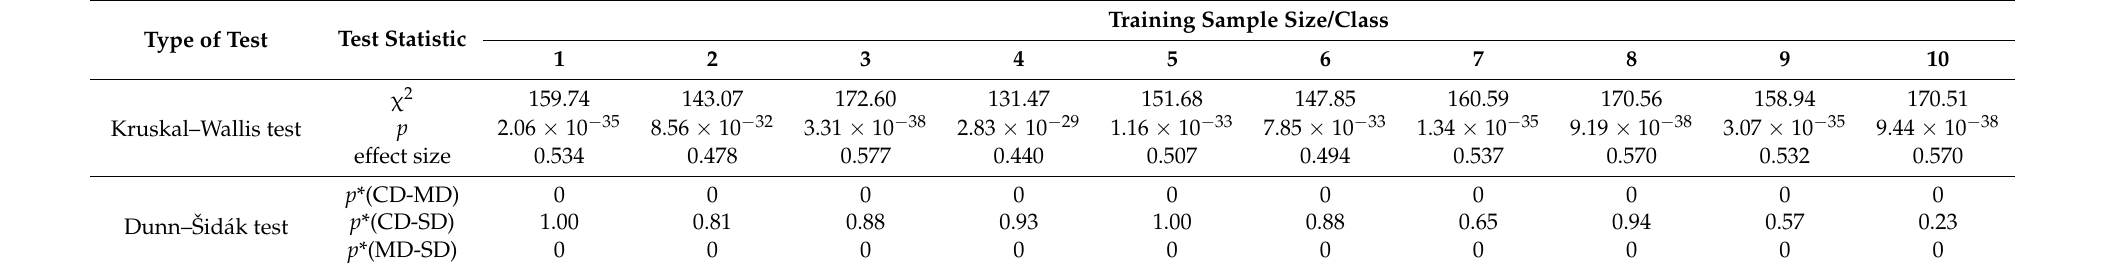
Table A3. Results of Kruskal–Wallis test and Dunn–Šidak post hoc test for decision tree algorithm ( α =